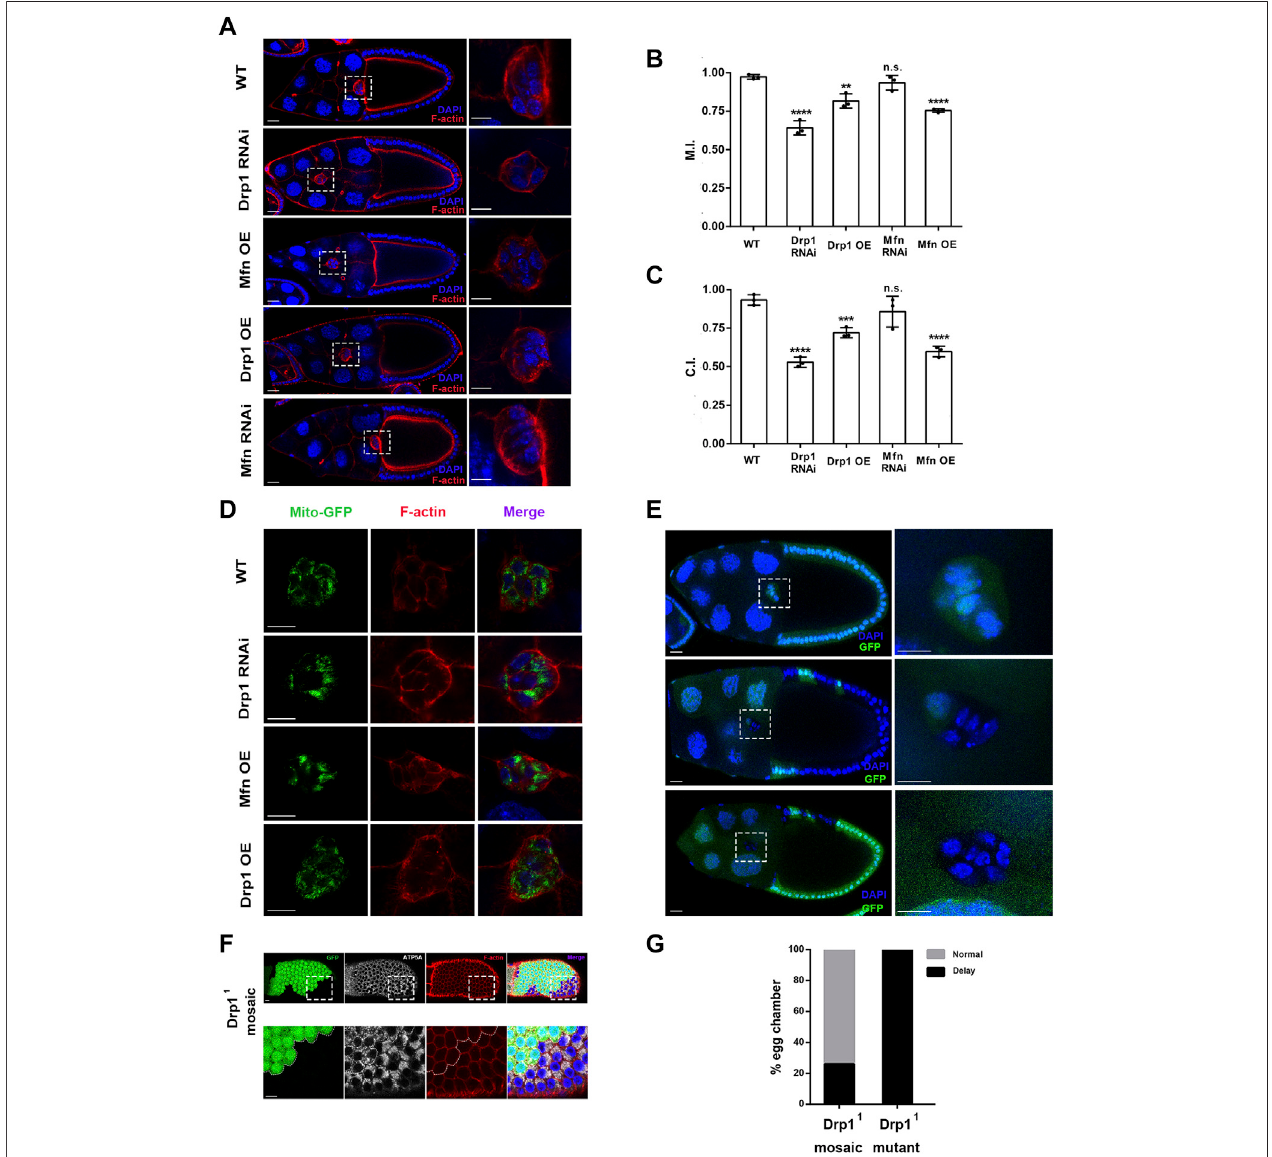
FIGURE 1 | Drp1-mediated mitochondrial fi ssion is required for border cell migration. (A) Confocal images of stage 10 egg chambers stained with phalloidin (for F-actin)andDAPI(for nuclei)withindicatedgenotypes.Bordercellclustersarehighlightedbytheboxedregions,whichareenlarged andshown totheright. Bordercells expressing Drp1 RNAi , Drp1 (i.e., Drp1 overexpression, Drp1 OE ) and Mfn ( Mfn OE ) by slbo-Gal4 failed to reach the oocyte border at stage 10 of oogenesis, whereas wildtype (WT) and Mfn RNAi expressing border cell cluster of stage 10 egg chamber has reached the oocyte border. (B) The migration index (M.I.) of border cells with Drp1RNAi , Drp1OE and MfnOE wassigni fi cantlyreducedascomparedtothecontrol,whereastheM.I.of MfnRNAi didnotshowsigni fi cantdifferencefromtheWT control.M.I.quanti fi esthemigratoryabilityofbordercellsandhasbeendescribedpreviously(Wangetal.,2018),andM.I.iscalculatedasfollowed:M.I.=[1×n(100%)+ 0.75×n(75%)+0.5×n(50%)+0.5×n(25%)+0×n(0%)]/n(total).n(total)representsthetotalnumberofstage10eggchambersexaminedforeachexperiment.Outof the total number, n (100%) represents the number of stage 10 eggchambers in which border cells have completed or migrated 100% of the migratory route, whereas n (0%), n (25%) ... represents number of stage 10 egg chambers where border cells have migrated 0%, 25% ... of the migratory route respectively. (C) The completion index (C.I.) of border cells with Drp1 RNAi , Drp1 OE and Mfn OE was signi fi cantly decreased as compared to the control, whereas the C.I. of Mfn RNAi , did not show signi fi cant difference from the control. C.I. represents another way to quantify the border cell migration and has been described previously (Combedazou et al., 2017), and it is calculated as followed: C.I. = n (100%)/n (total). n (total) represents the total number of stage 10 egg chambers examined for each experiment, and n (100%) represents the number of stage 10 egg chambers where border cells have completed 100% of the migratory route. Three experiments have been repeated for each genotype (thus three data points for each genotype), and a total of 286, 186, 178, 165, and 335 egg chambers have been examined for WT, Drp1 RNAi , Drp1 OE , Mfn RNAi , and Mfn OE respectively for the M.I. or C.I. determination. (D) Single confocal sections of egg chambers stained with Mito-GFP (for mitochondria), phalloidin and DAPIwithindicatedgenotypes.HighresolutionimageswereacquiredwithZeiss880,usingAiryscansetting(nearsuper-resolution).PatchesofstrongGFP fl uorescence in Drp1RNAi and MfnOE indicateincreaseofmitochondrialfusionascomparedtothecontrol. (E) Imagesofstage10eggchamberswithbordercellclusterscomposed ( Continued )